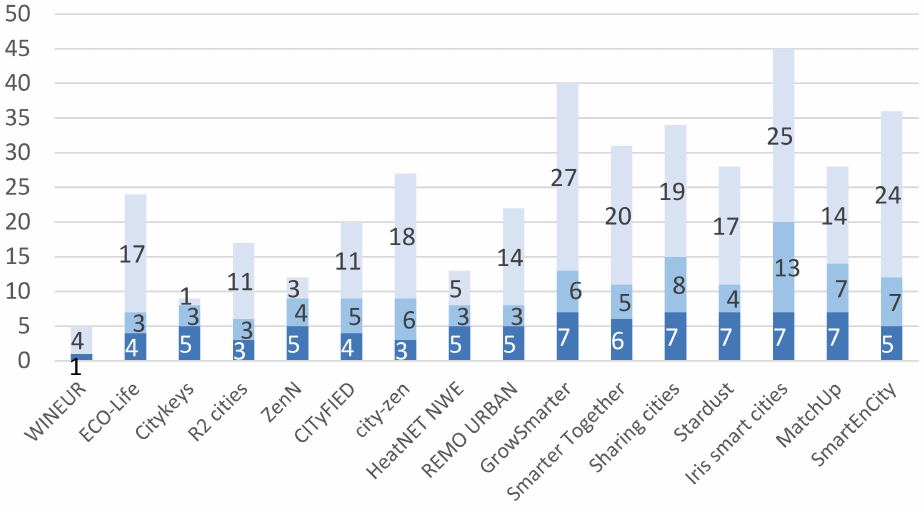
Figure 3. Types of partners in the 16 projects